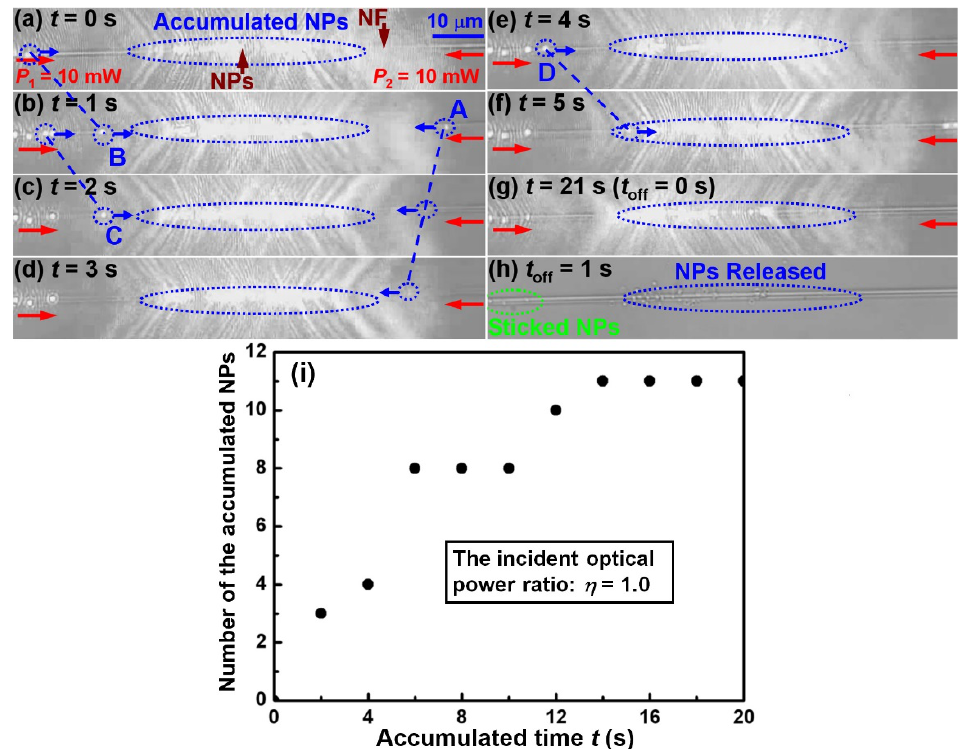
Figure 2. Bidirectional accumulation of NPs and release. ( a − f ) Accumulation of NPs (labeled as A, B, C, D) for t = 0 to 5 s with the same incident optical power ( P 1 = P 2 = 10 mW, i.e., η = P 2 / P 1 = 1) at both ends of the NF. ( g ) Microscope image of the laser just before being turned off (i.e., t off = 0 s, corresponding t = 21 s). ( h ) Release of the accumulated NPs at t off = 1 s. Detailed bidirectional accumulation and directional release process from t = 0 to 22 s is shown in Media S1. ( i ) Number of accumulated NPs in the corresponding accumulated time.